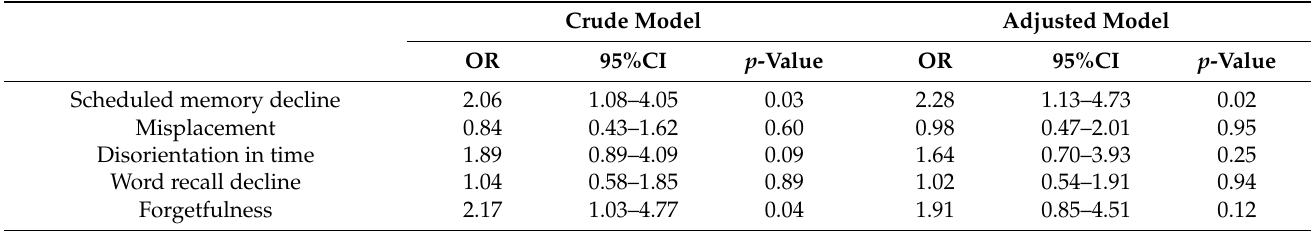
Table 3. Association between the sleep onset problem and subjective cognitive